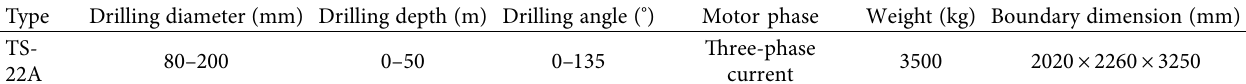
Table 1: The technical parameters of the crawler anchor rope